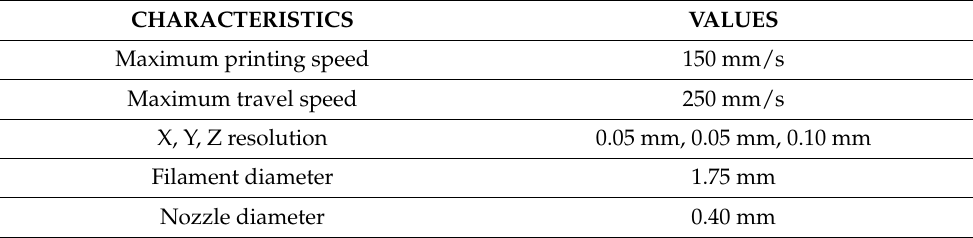
Table 1. Configuration of the FDM 3D printer “Artillery Genius” selected for the study